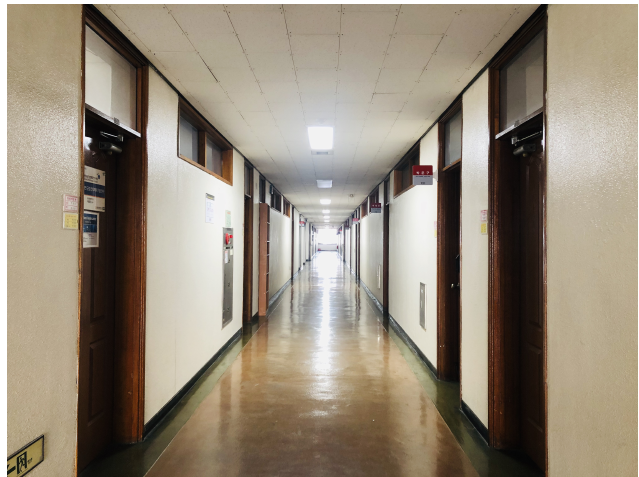
Figure 6. Indoor experiment environment at the 3rd floor of IT-1 building.